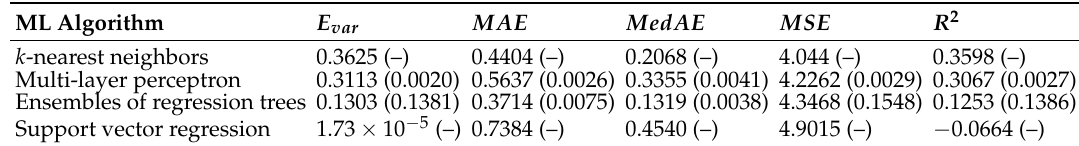
Table 4. Quality metrics per model. Average (and standard deviation) is shown for stochastic models. Only the best setup based on mean MSE is shown. Price in